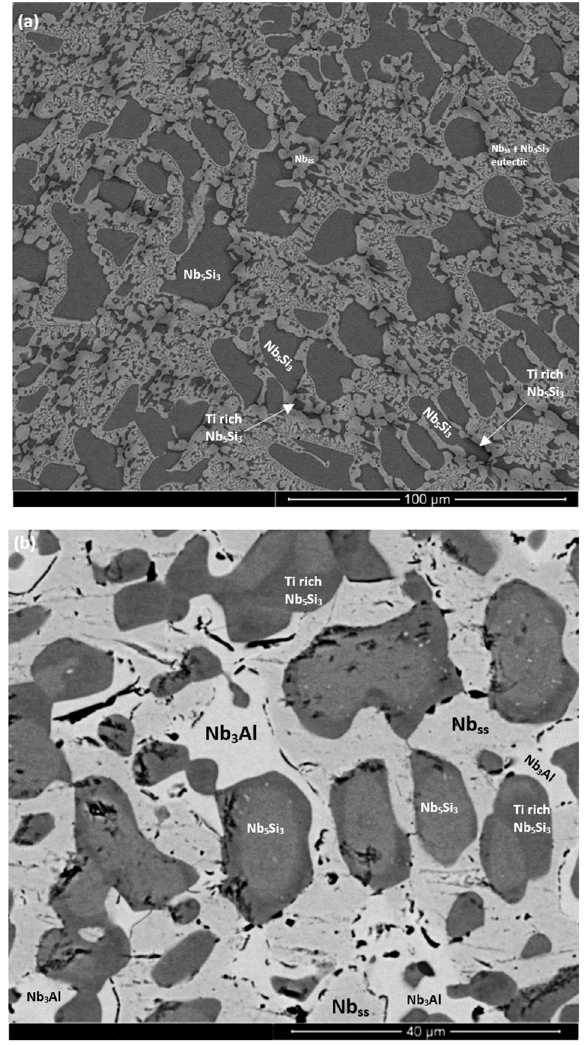
Figure 2. BSE images of the microstructure ( a ) of the bulk of the cast and ( b ) heat-treated alloy ZX5. Table 1. Comparison of phases present in the cast and heat-treated alloys ZX3, ZX5, and ZX7. As-Cast Heat-Treated Alloy Composition Phases Composition Phases